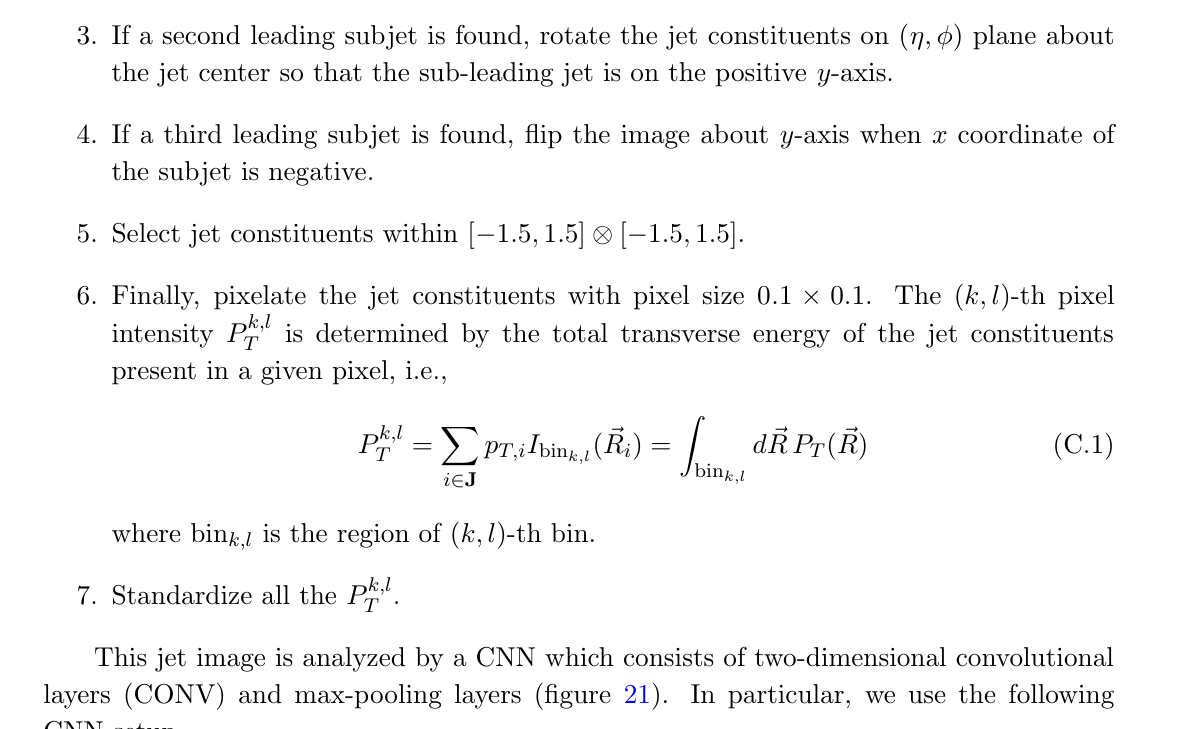
JHEP07(2019)135